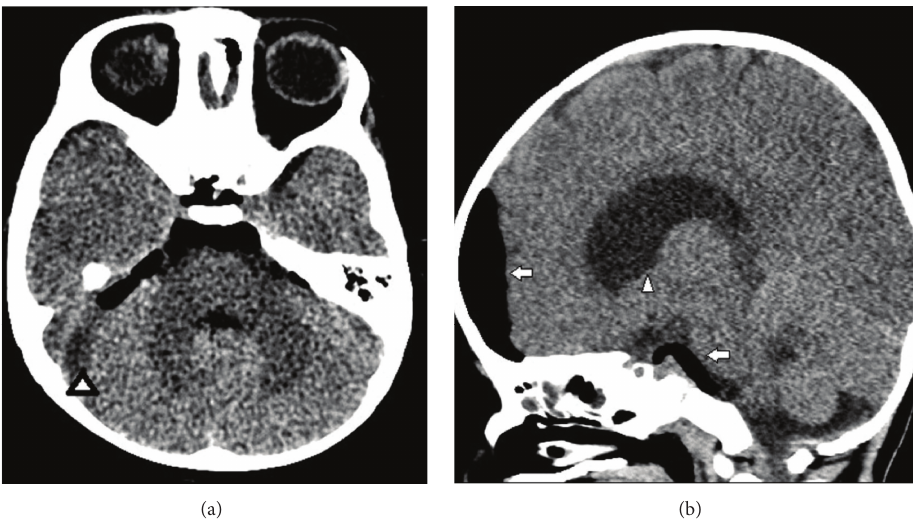
Figure 2: Head CT on day 2 for evaluation of meningitis. (a) Axial head CT shows subdural effusion over the right cerebellar hemisphere abutting the sigmoid sinus (arrowhead) and large air in the prepontine cistern. (b) Sagittal reformat demonstrates large pneumocephalus over the left frontal lobe and in the prepontine cistern (arrows). There is mild lateral ventricle dilatation (arrowhead).